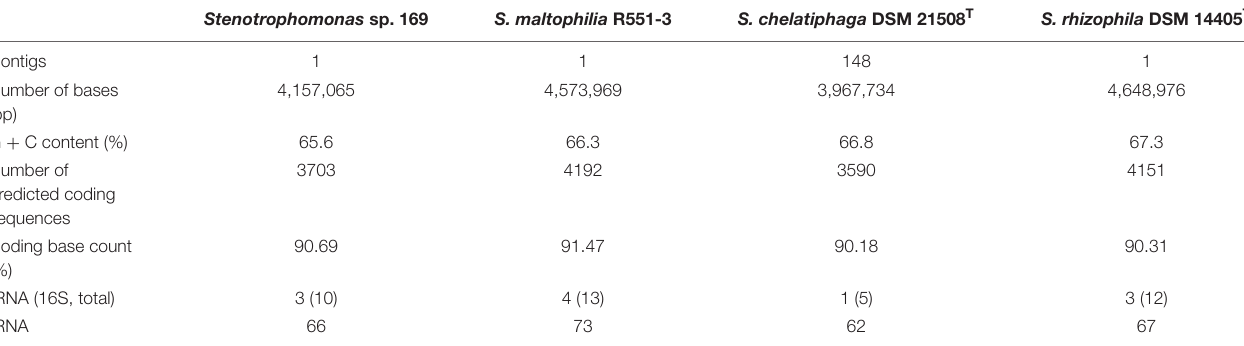
TABLE 1 | Summary of the genomic characteristics of Stenotrophomonas sp. 169 in comparison to S. maltophilia R551-3, S. rhizophila DSM 14405 T , and S. chelatiphaga DSM 21508 T .